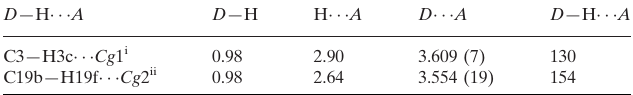
Hydrogen-bond geometry (A˚ , (cid:3)